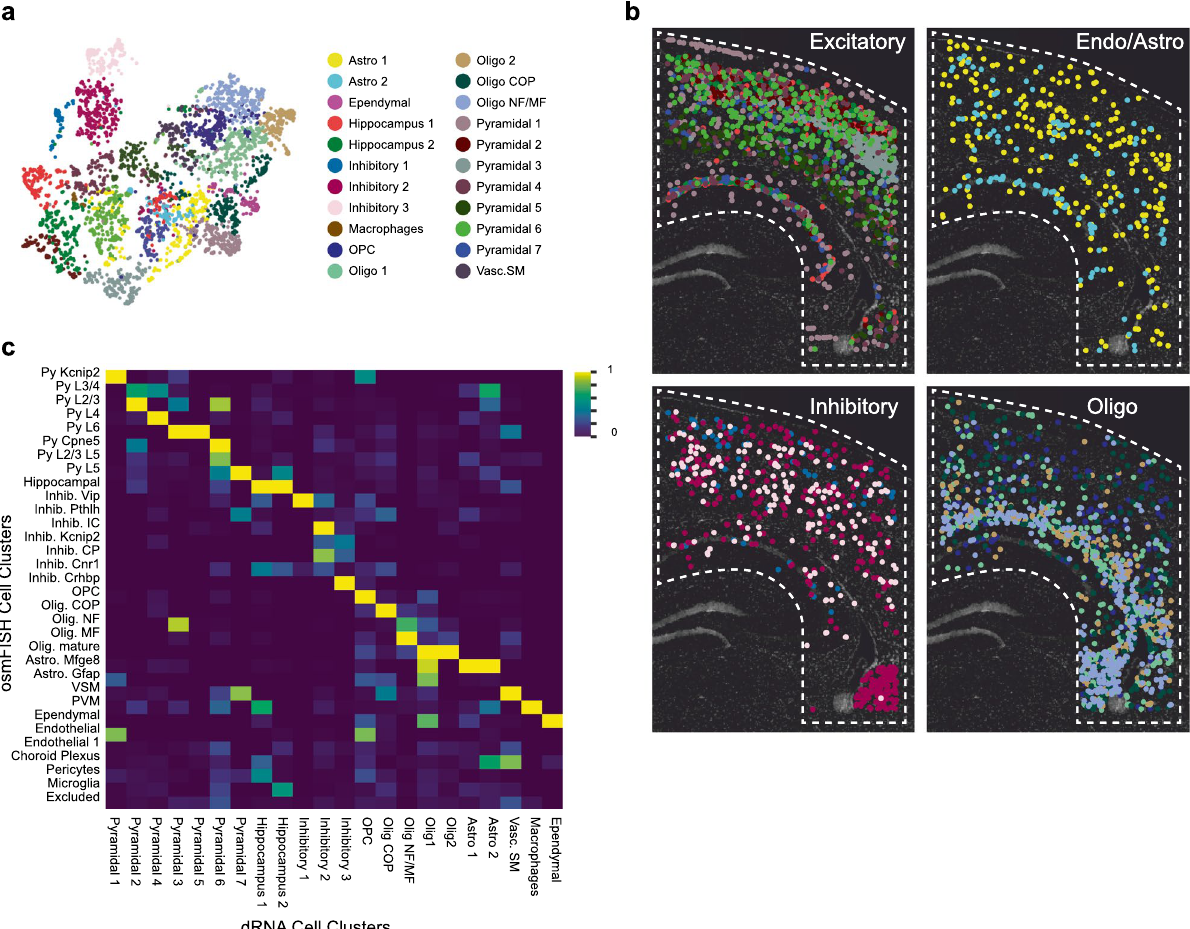
Figure 3. De novo clustering of somatosensory cortex region and comparison to osmFISH cell type clustering. ( a ) UMAP of cell clusters using 33-gene panel within outline ROI. ( b ) Cell-type map of most cell clusters superimposed on DAPI nuclear image. All cell clusters mapped in Supplementary Fig. 8c. ( c ) Similarity map of osmFISH cell clusters compared to dRNA-HybISS de novo clusters obtained by integrating both datasets using Spatial Gene Enrichment (SpaGE) 25 . Color bar corresponds to normalized similarity between clusters detected in both